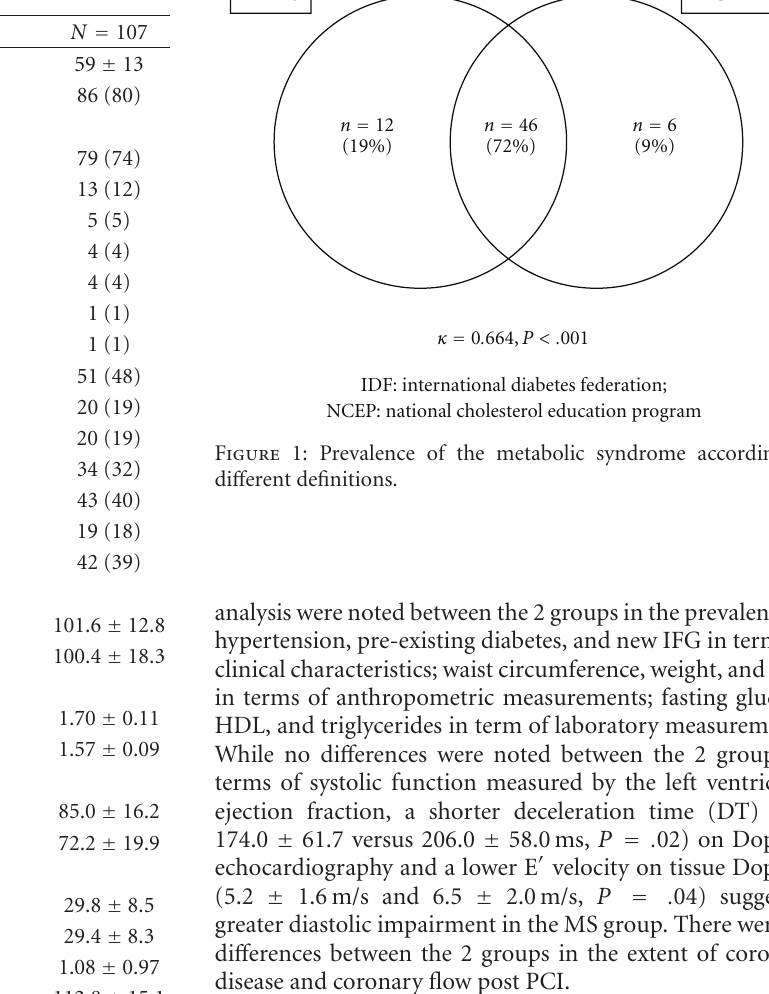
Table 1: Baseline characteristics of patients.